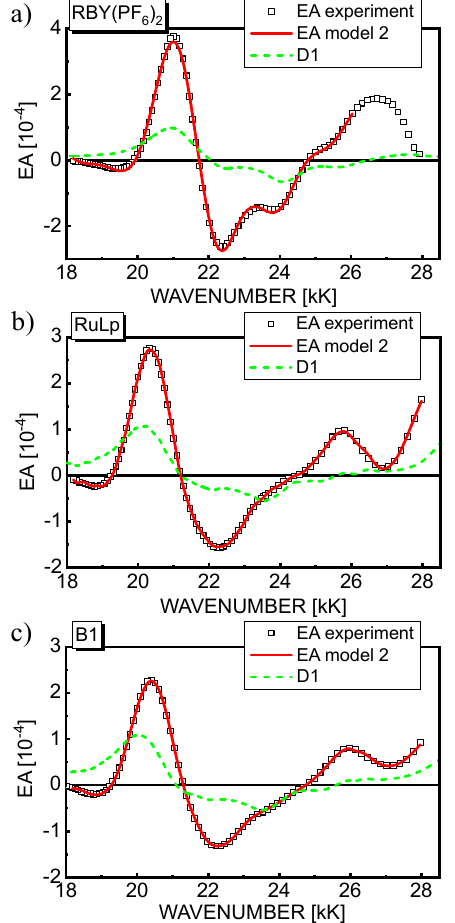
Figure 7. The best fits of EA spectra, taken from Figures 4–6, obtained on the basis of model 2 for the films of Ru(II) complexes: RBY(PF 6 ) 2 ( a ), RuLp(PF 6 ) 2 ( b ), and B1(PF 6 ) 4 ( c ). The contribution of the first derivative (D1) of the respective global absorption spectrum to the EA signal (see Equation (9)) is shown by the dashed line.